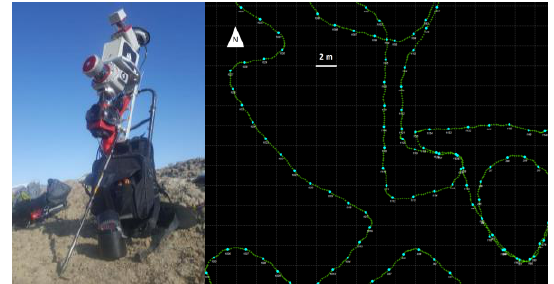
Figure 1. A: AkhkaR4DW backpack. GNSS antenna on top, the IMU between the two scanners, GNSS receiver is in the bag. The primary scanner provides nominally vertical scanning, while the secondary scanner on the top is tilted 30 degrees. The panoramic multi camera is at the bottom. B: Post-processed trajectory and camera exposure markers at 0.5 Hz.